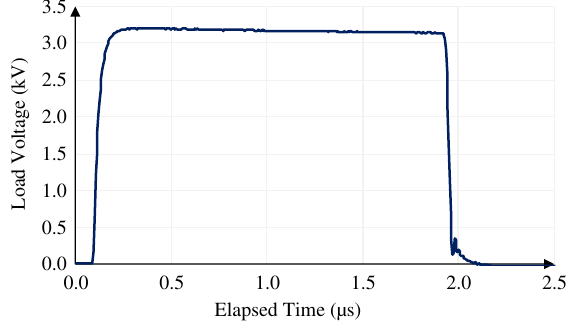
FIG. 10. Measured load voltage pulse for four Marx stages (precharge ¼ 800 V = stage) into a 1 . 18 Ω resistive load.